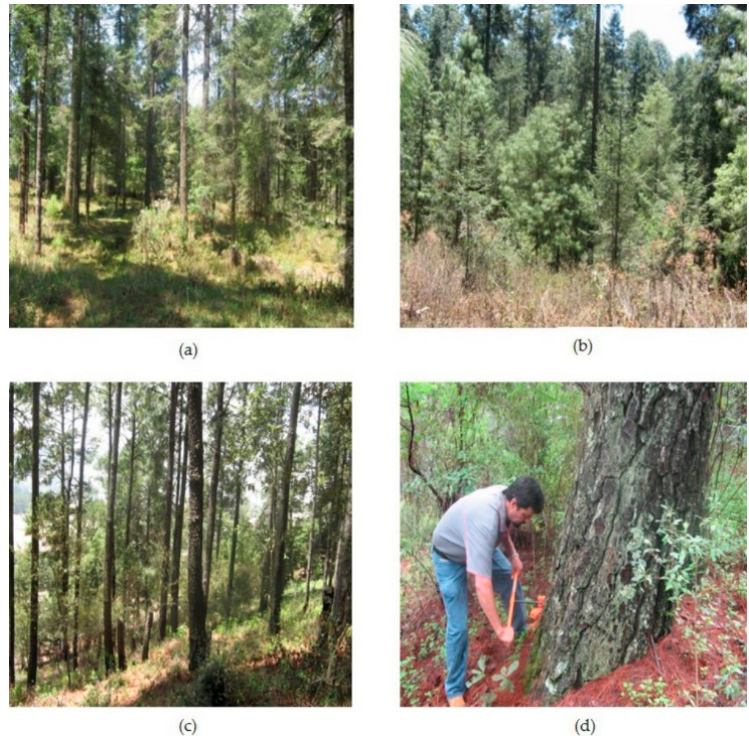
Figure 2. Stands dominated by A. religiosa ( a ), co-dominated by A. religiosa and P. pseudostrobus ( b ), dominated by P. pseudostrobus ( c ), and extraction of increment cores ( d ).